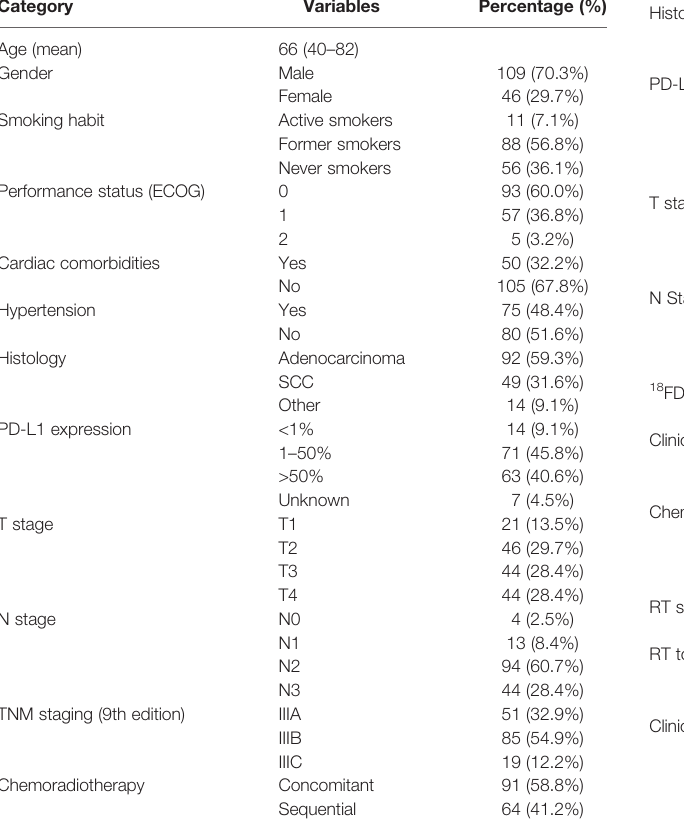
TABLE 1 | Patients ’ characteristics.